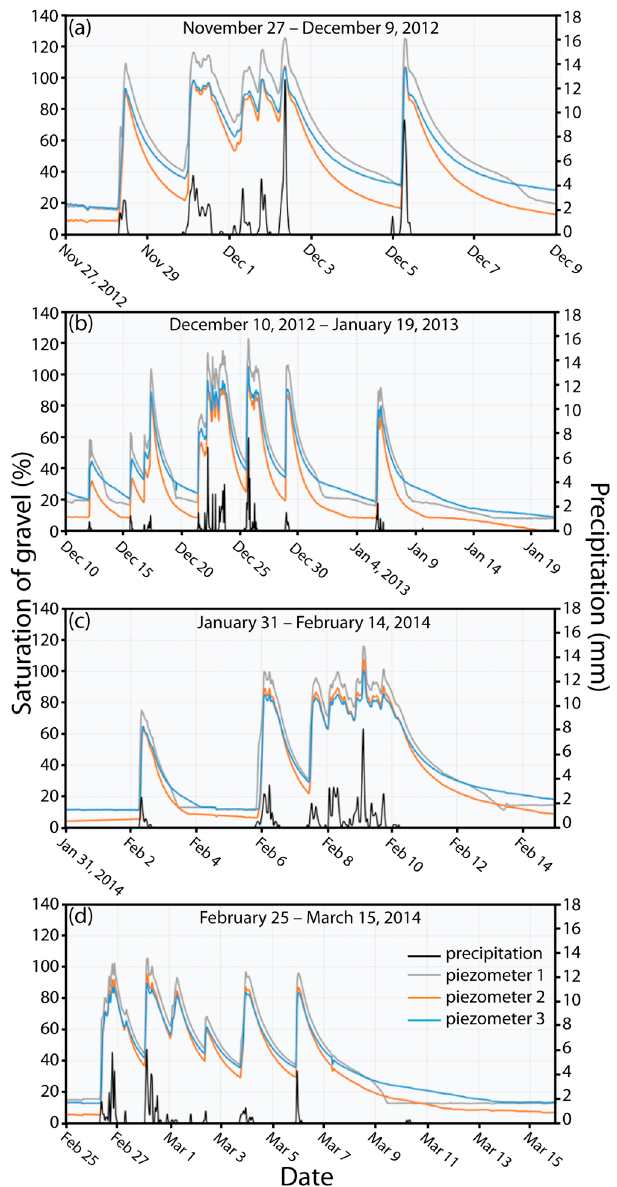
Figure 4. Hourly time series of precipitation (mm) and saturation of gravel (%) for piezometers 1, 2, and 3 during the rainy season of: ( a , b ) 2012–2013; and ( c , d ) 2014.